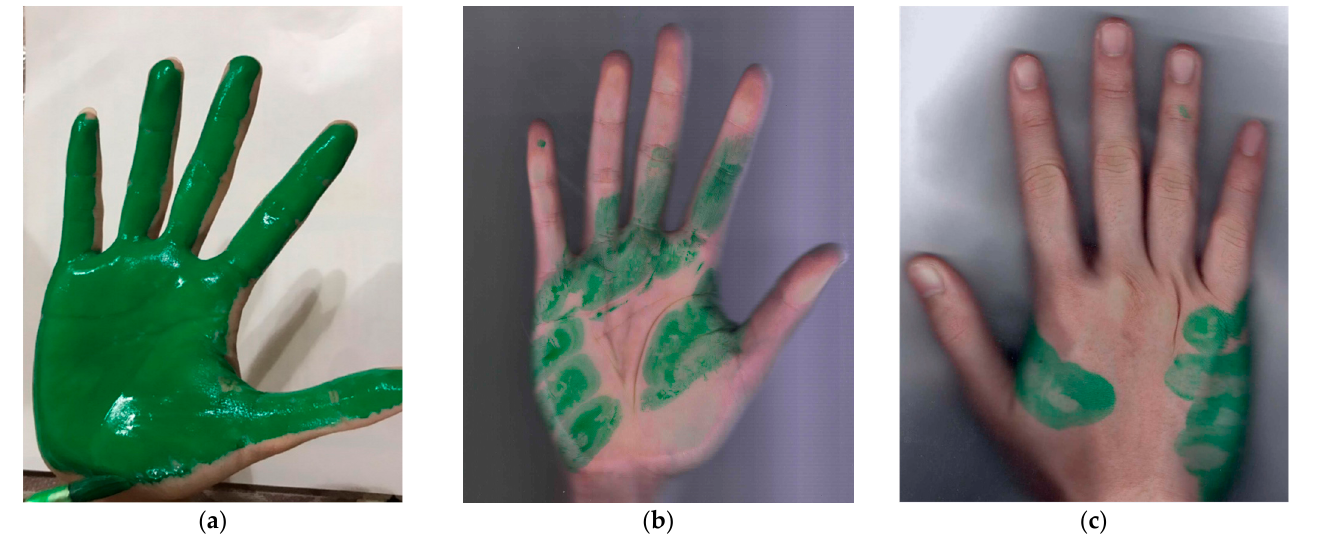
Figure 6. Normalization of palm: ( a ) Points P1–P4 and lines m and n defined on palm of hand. The angle was adjusted so that line m was horizontal. ( b ) Normalization was conducted such that the lengths of lines m and n were 500 mm and 1500 mm, respectively.